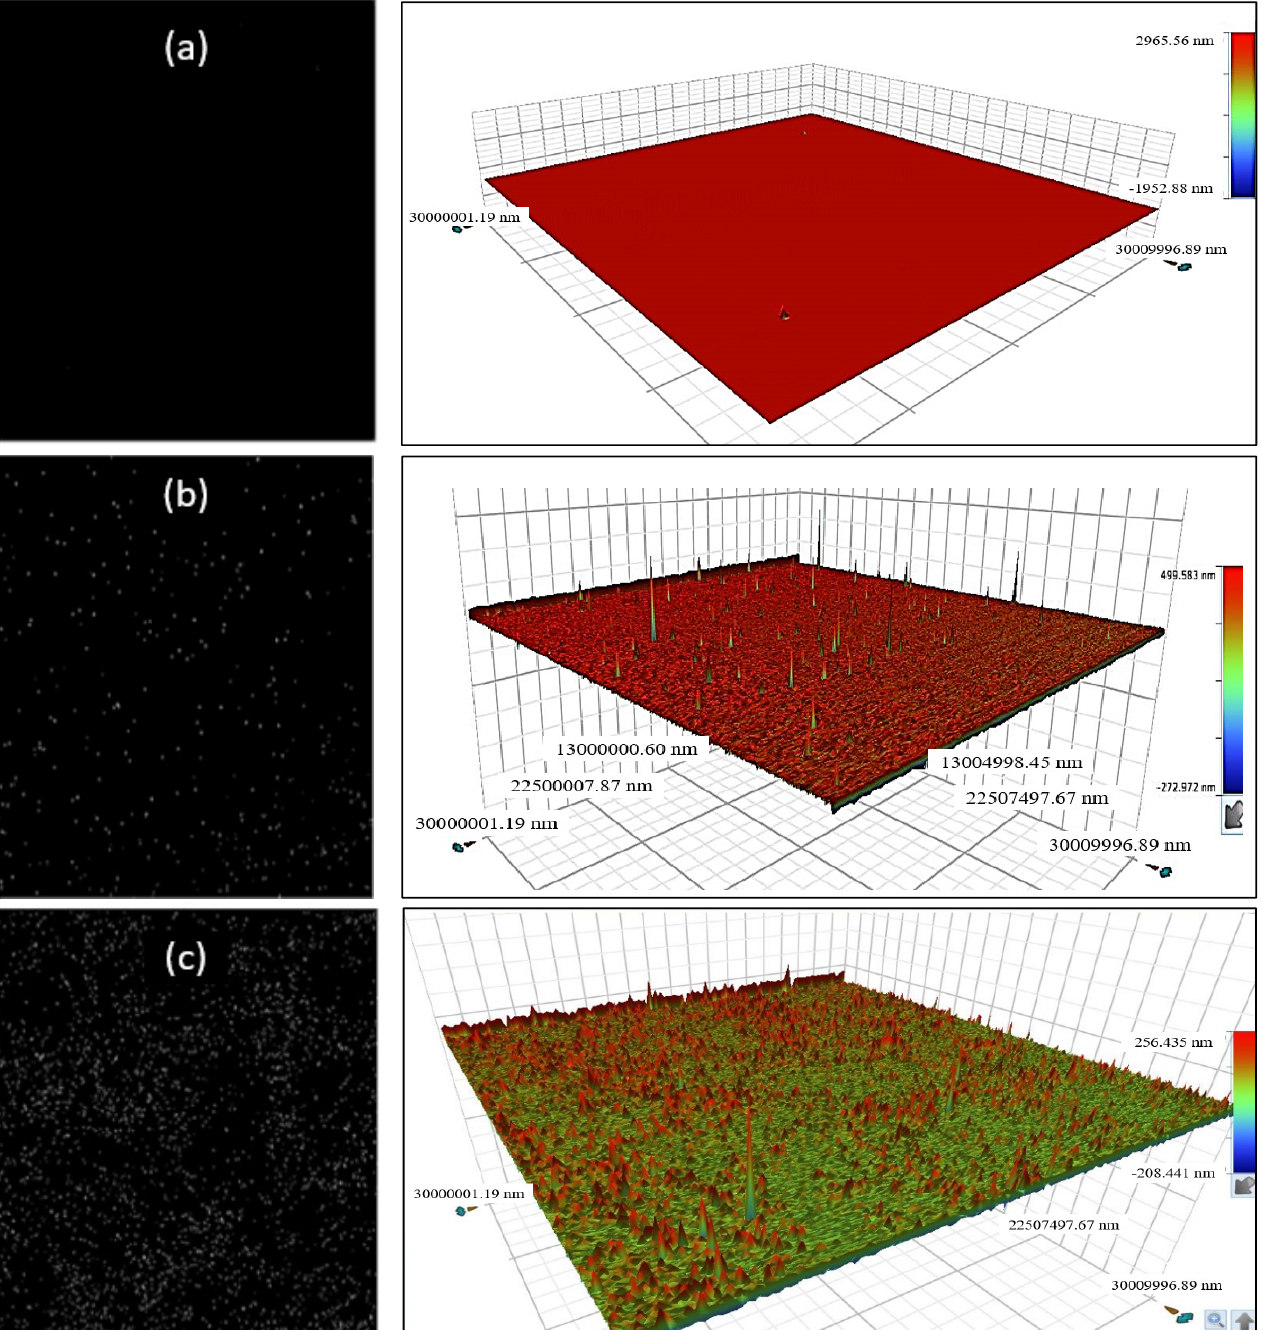
Figure 15. 1D and 3D surface profile of uncoated intact samples; ( a ) initial; ( b ) after 48 h of HAST test; ( c ) after 170 h of SUN test.